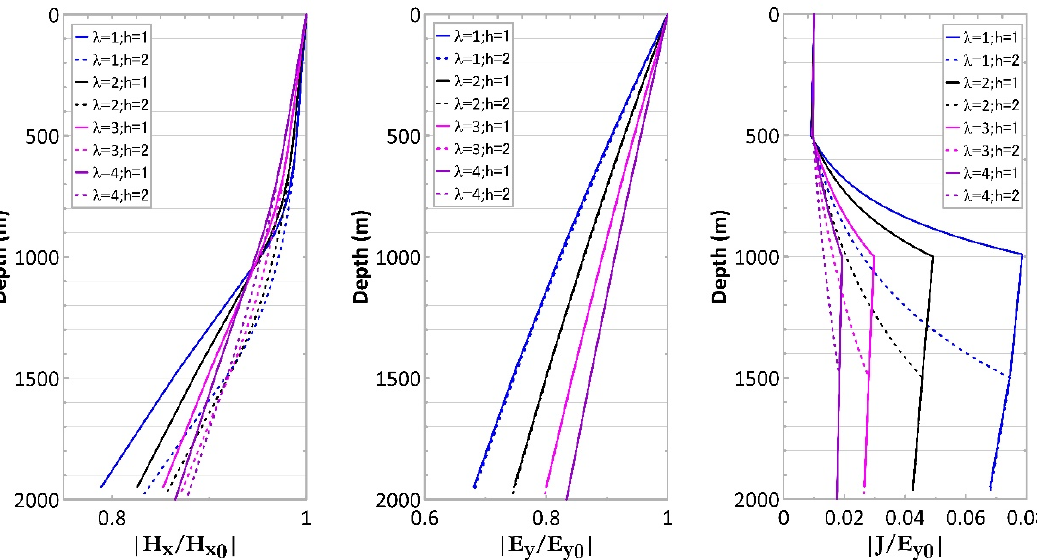
Figure 6. Similar to the case shown in Figure 5 except that the anisotropic dip angle is 30° in the model.